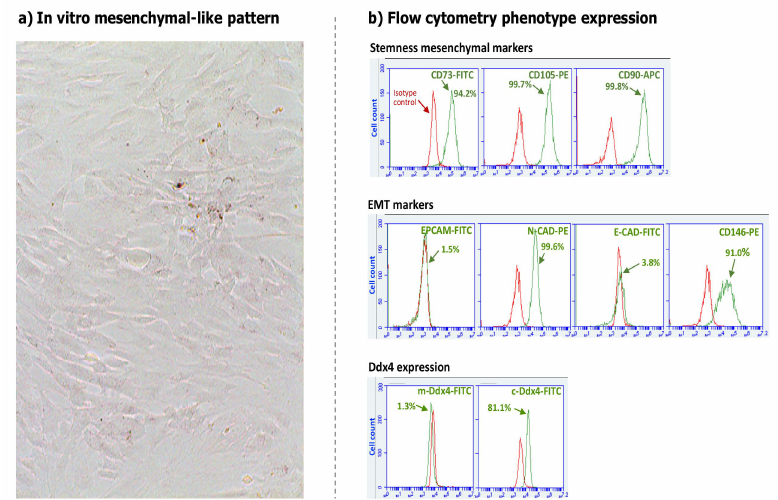
Figure 5. In vitro mesenchymal di ff erentiation and phenotype analysis of cultured Ddx4 + cells. ( a ) Light microscope image of 15-day cultured Ddx4 + cells in FSH and EGF-supplemented medium showing morphological variation from round to “spindle-like” adherent cells, with a typical aspect of fibroblasts or mesenchymal stem cells. ( b ) Flow cytometry analysis of cultured cells showed a mesenchymal phenotype with typical stemness markers (up), also including the epithelial-to-mesenchymal transition (EMT) molecules as N-cadherin (N-CAD) and CD146, whereas no epithelial markers as EPCAM and E-cadherin, were detected (middle). Based on their di ff erentiation to the mesenchymal phenotype, OSCs lost Ddx4 membrane expression while the molecule was detectable in cytoplasm (down). Red histograms represent isotype controls used in flow cytometry